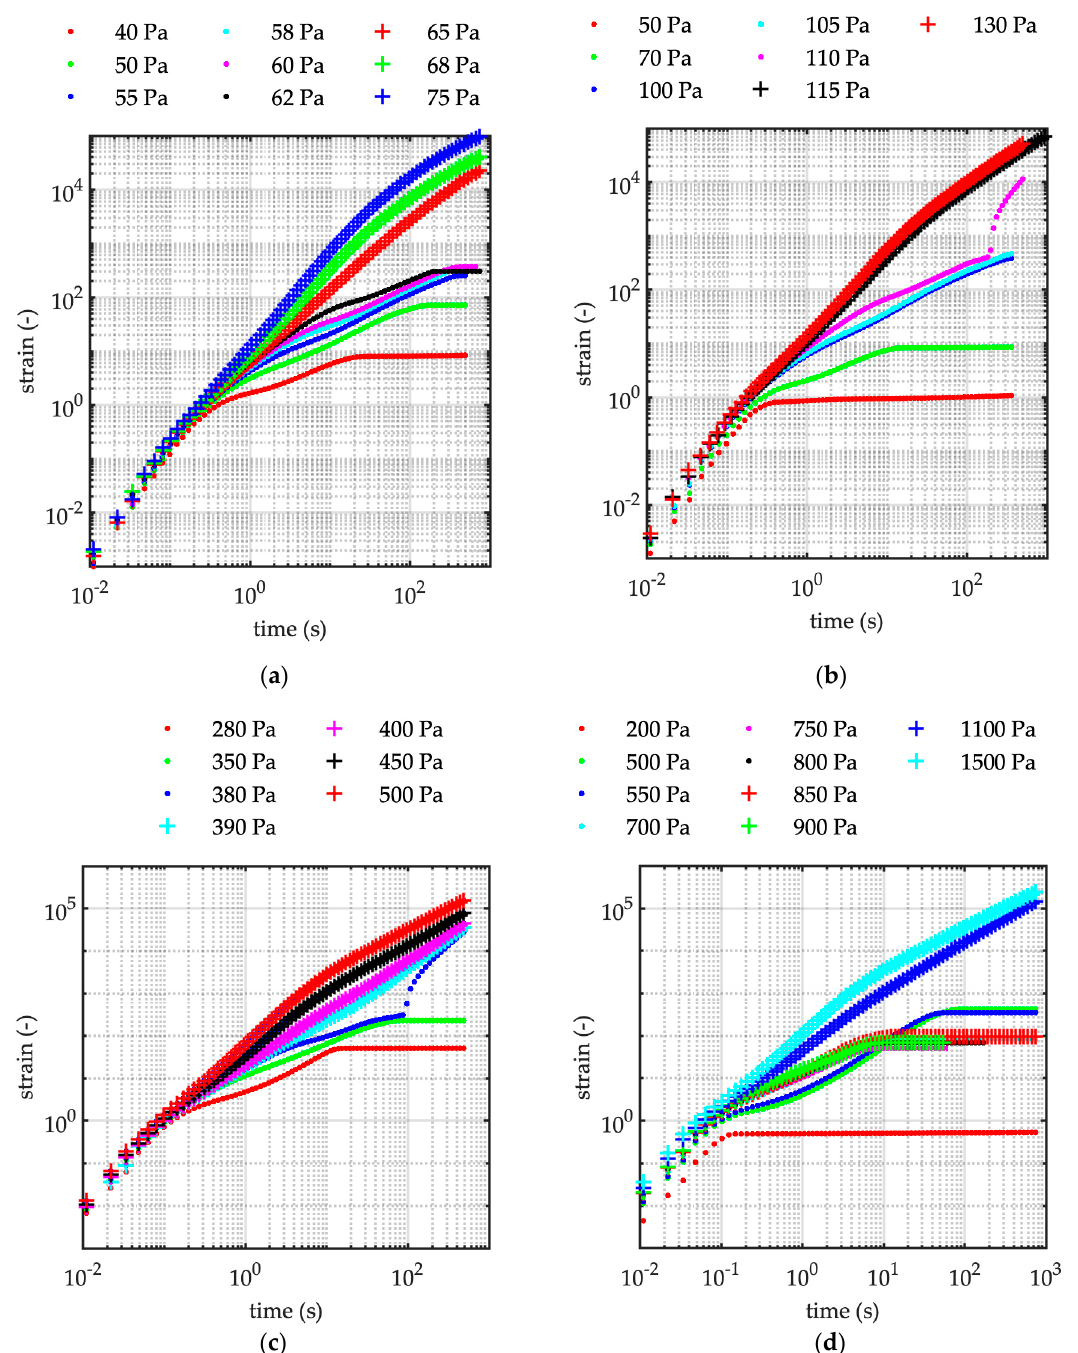
Figure 2. Creep tests. The time–strain trend during the test. ( a ) Sediment concentration C = 50%. Runs C87–C95 (see Table 2) corresponding to the increasing applied shear as it is reported in the legend. ( b ) Sediment concentration C = 52%. Runs C36–C42 (see Table 2) corresponding to the increasing applied shear as it is reported in the legend. ( c ) Sediment concentration C = 56%. Runs C59–C65 (see Table 2) corresponding to the increasing applied shear as it is reported in the legend. ( d ) Sediment concentration C = 58%. Runs C96–C104 and Run C108 (see Table 2) corresponding to the increasing applied shear as it is reported in the legend.